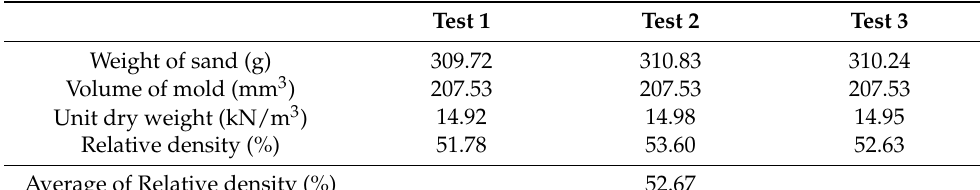
Table 4. Relationship between relative density and soil condition of the sand [20].